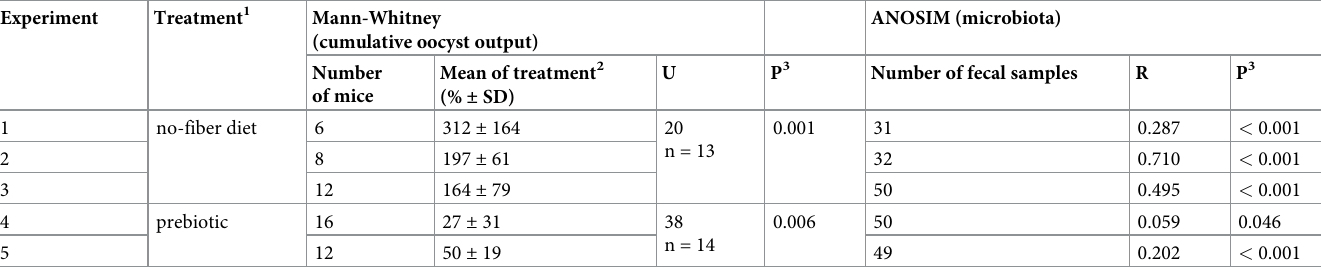
Table 2. Summary of oocyst enumeration and 16S amplicon sequence analysis.